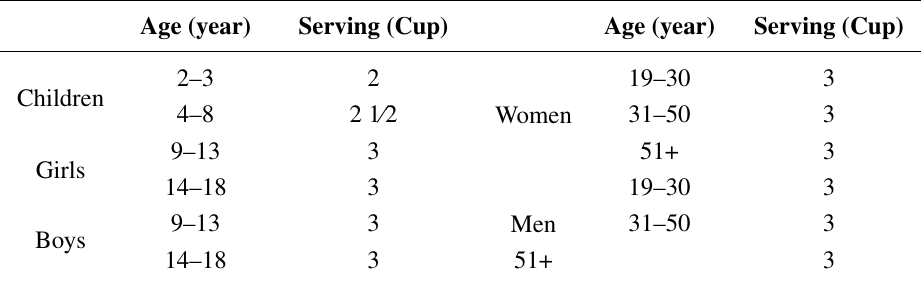
Daily recommendation of drinking milk by the United State Department of Agriculture (USDA)